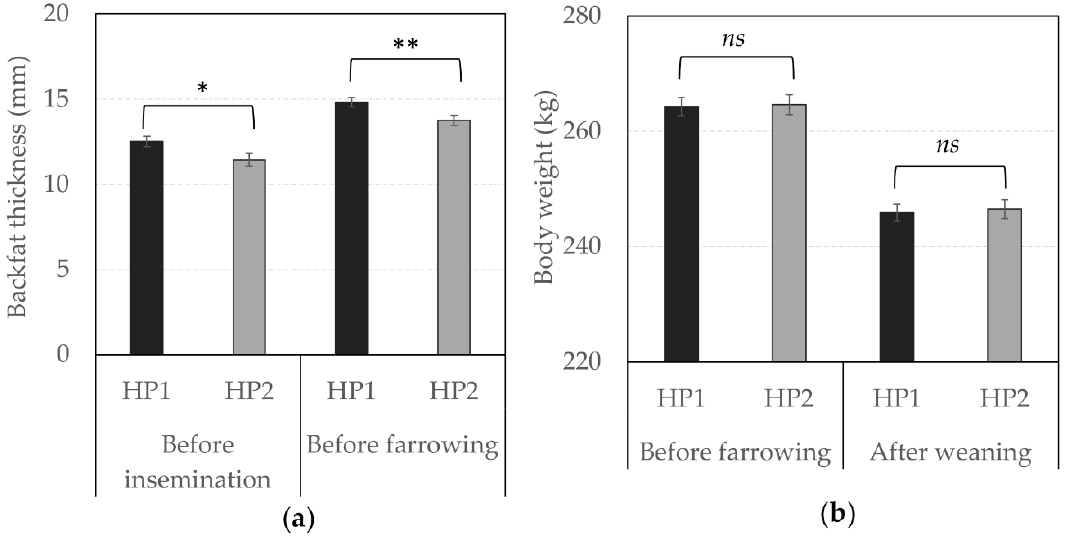
Figure 3. Individual performance according to genetic line. Average ( ± SEM) ( a ) backfat thickness (in mm) before insemination and before farrowing and, ( b ) body weight (in kg) before farrowing and after weaning in HP1 and HP2. *, ** Means differ significantly (* p < 0.050, ** p < 0.010) between genetic lines for a same recording phase; ns —not significant.